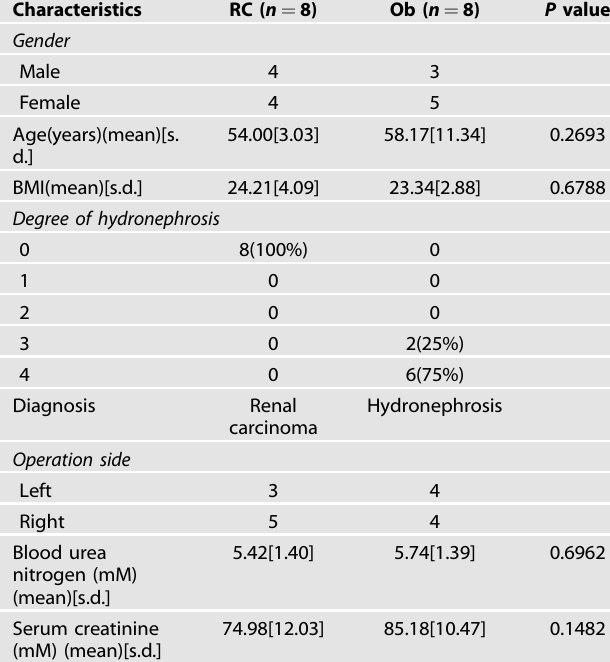
Table 1. The basic clinical information of renal carcinoma (RC) patients and Ob